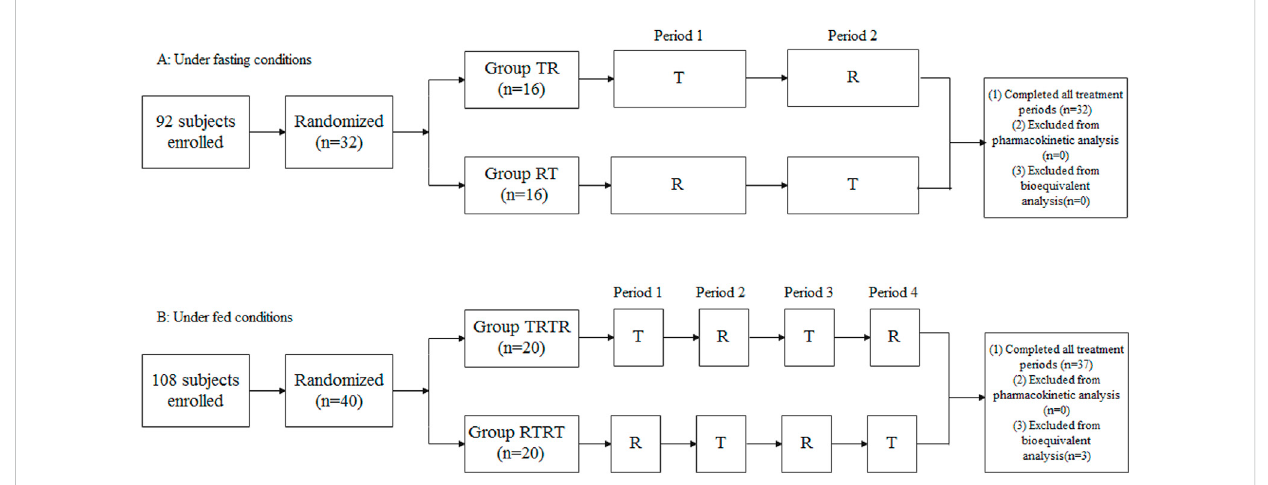
FIGURE 1 Study design and disposition of subjects. (A) Under fasting conditions, (B) Under fed